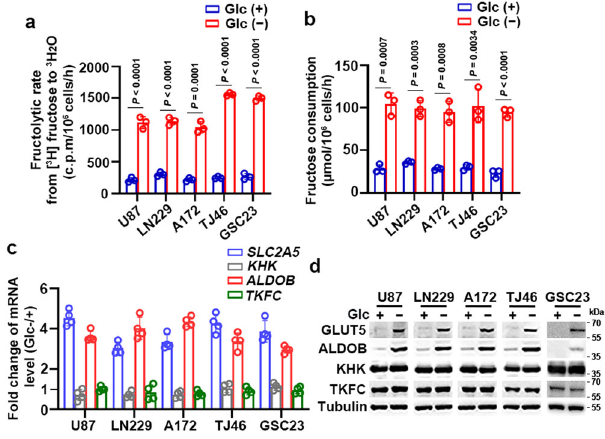
Fig. 1 | Glucose deprivation promotes fructolysis. a U87, LN229, A172, TJ46, and GSC23 cells were deprived of glucose for 18h. The fructose metabolic rate was measured by monitoring the conversion of D-[5- 3 H] fructose to 3 H 2 O and normal- izedtocellnumber.c.p.m,countsperminute. b U87,LN229,A172,TJ46,andGSC23 cells were deprived of glucose for 18hours and then incubated with 10mM of fructose for another 18hours. The media were collected for analysis of fructose consumption. c , d U87, LN229, A172,TJ46, and GSC23cellsdeprived of glucose